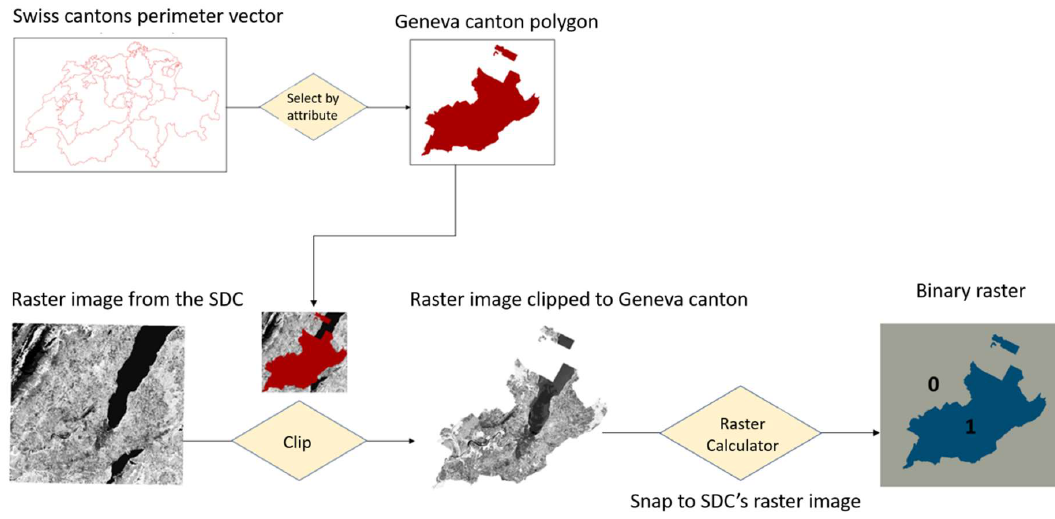
Figure 2. Creation of a binary raster mask.